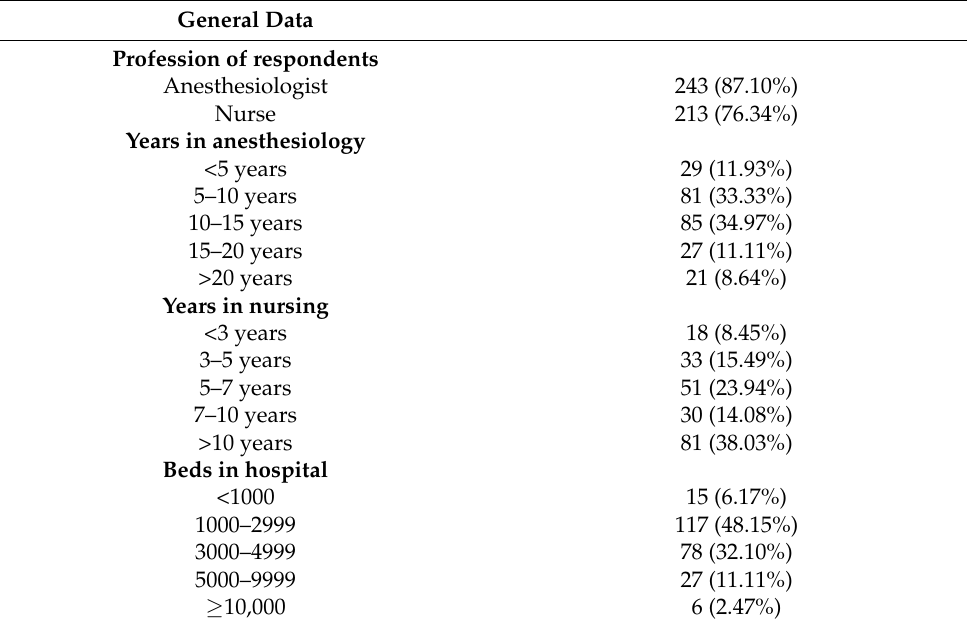
Table 1. General data and characteristics of the